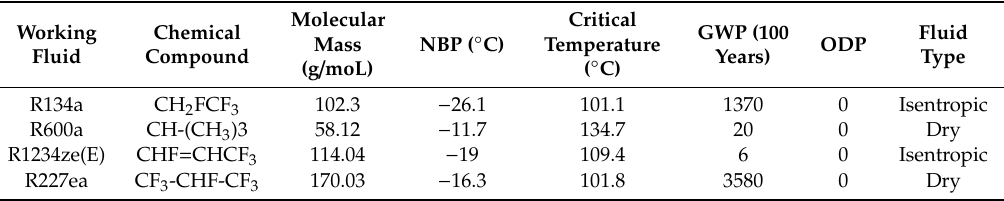
Table 1. Properties of working